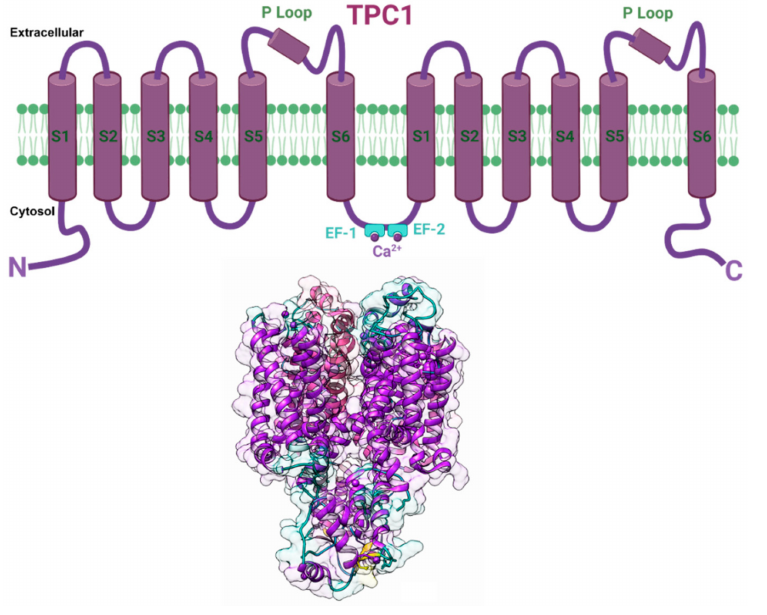
Figure 6. Putative structure of TPC1 channel. (Top) Schematic cartoon representation of individual plant TPC1 channel subunit comprising two repeated domains showing six membrane-spanning regions (S1–S6), two pore loops (P), and joined via a cytosolic linker containing two Ca 2+ binding EF-hands (EF1 and EF2). (Bottom) TPC1 secondary 3D structure model showing two subunits in transparent surface view was developed from PDB structure 5DQQ ( Arabidopsis thaliana TPC1). The image was prepared using Chimera software [122]. Created with BioRender.com (accessed on 30 August